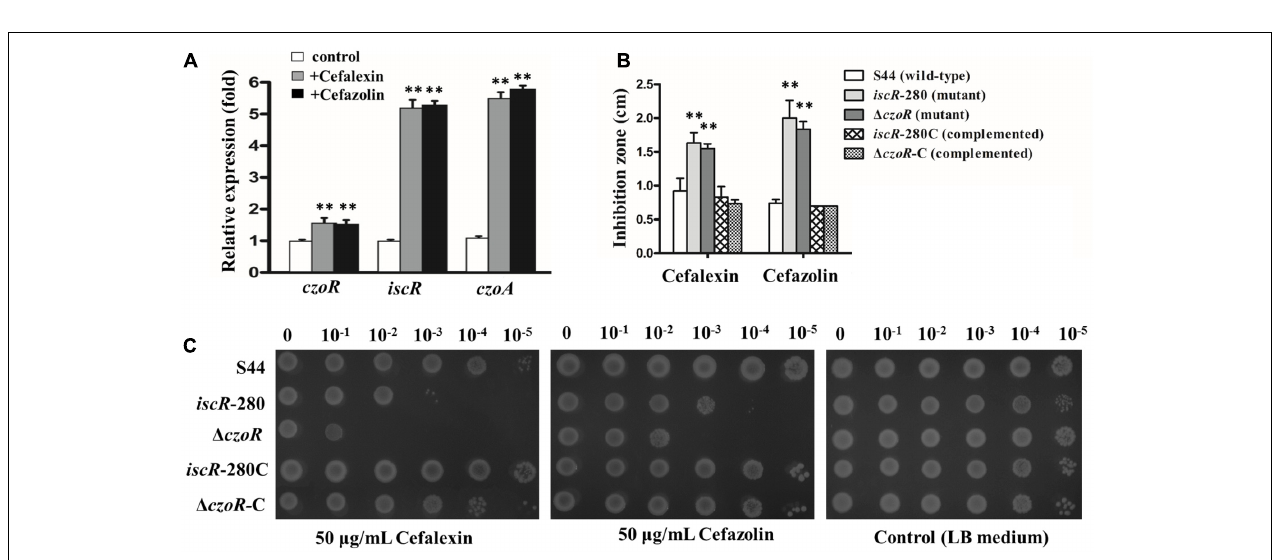
FIGURE 3 | IscR and CzoR contribute to cephalosporin susceptibility. (A) Transcriptional levels of czoR , iscR , and czoA in S44 with or without (white bars) addition of 25 µ g/ml of cefalexin (dark gray bars) and cefazolin (black bars). (B) Susceptibility tests of strains S44, iscR-280 , iscR -280C, (cid:49) czoR , and (cid:49) czoR-C to different antibiotics (cefalexin and cefazolin) were determined using the Kirby–Bauer disk diffusion method. The inhibition zone of each disk was measured to the nearest millimeter. The diameter (0.7 cm) of susceptibility disks was counted in the inhibition zones. (C) Spotting assays for growths of strains S44, iscR -280, iscR -280C, (cid:49) czoR , and (cid:49) czoR- C on LB plates without antibiotics and those supplemented with 50 µ g/ml cefalexin or cefazolin. Ten-fold serial dilutions of each culture were inoculated on the plates and incubated at 37 ◦ C for 48 h. Error bars represent standard deviations of triplicate tests. ∗∗ Indicates a significant difference from the control ( p < 0.01, Student’s t